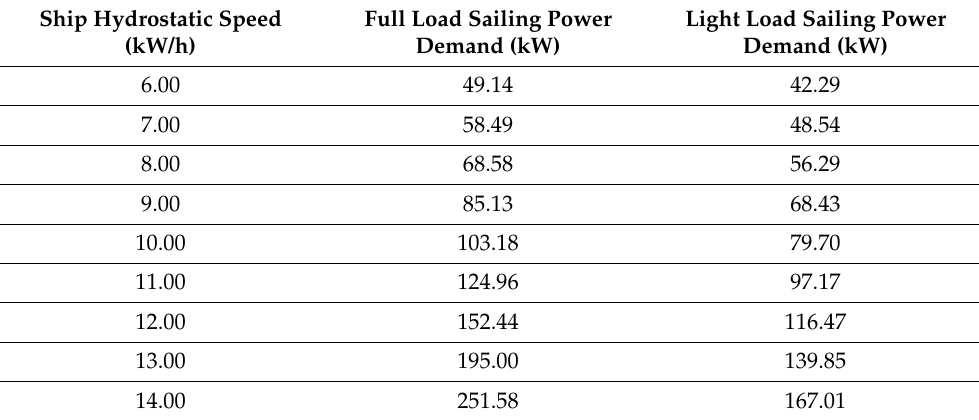
Table 1. Design parameter of a battery-only powered inland water ship.